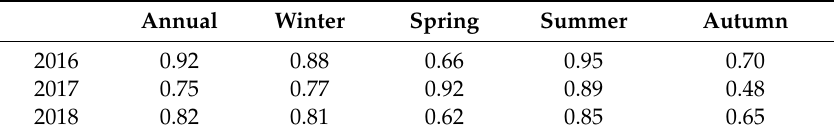
Table 1. Pearson’s r correlation coefficient per year and per season.